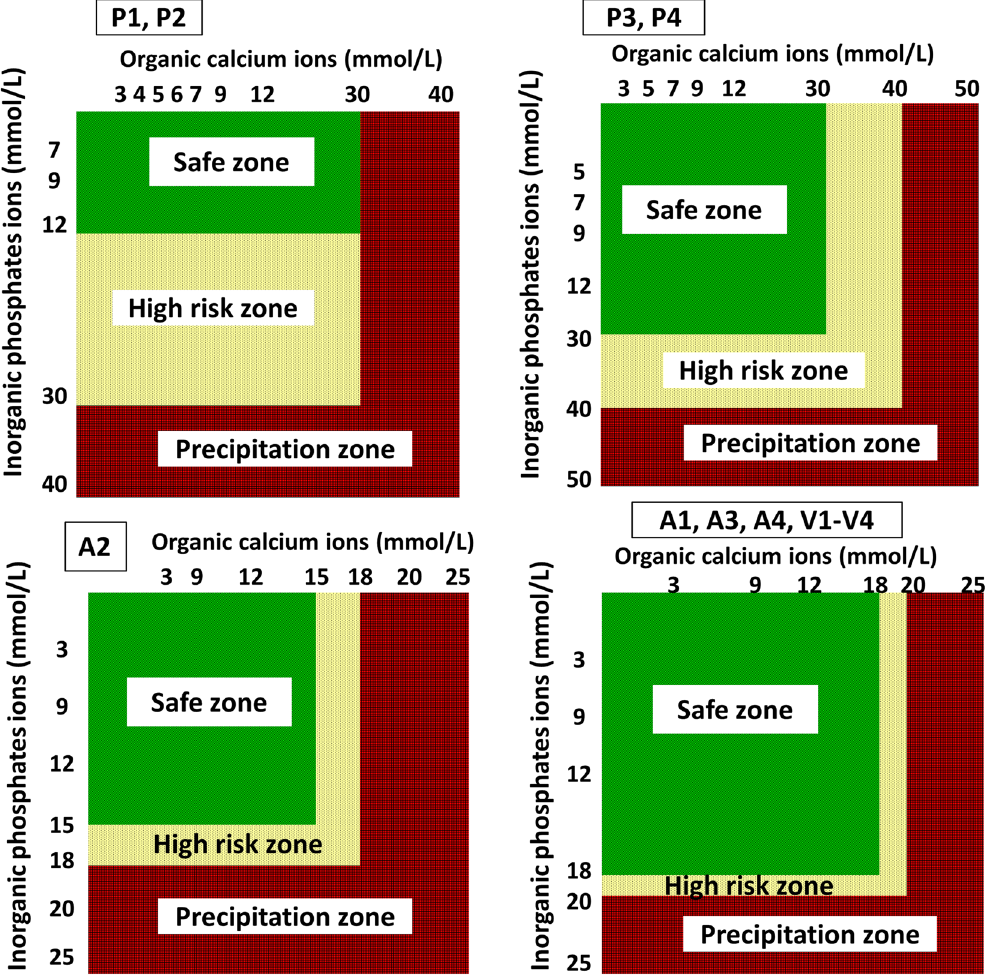
Figure 2. Stability and precipitation zones of PN solution in respect of the concentration of organic calcium and inorganic phosphate ions (t = 24 hr, 37